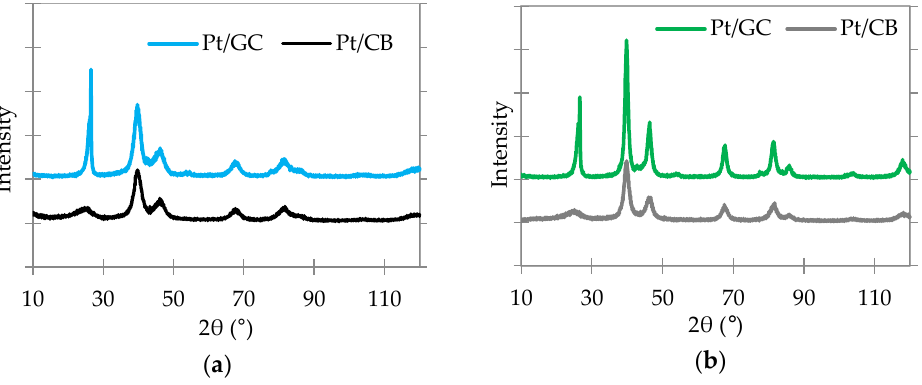
Figure 2. XRD patterns of the catalysts ( a ) before annealing and ( b ) after annealing.